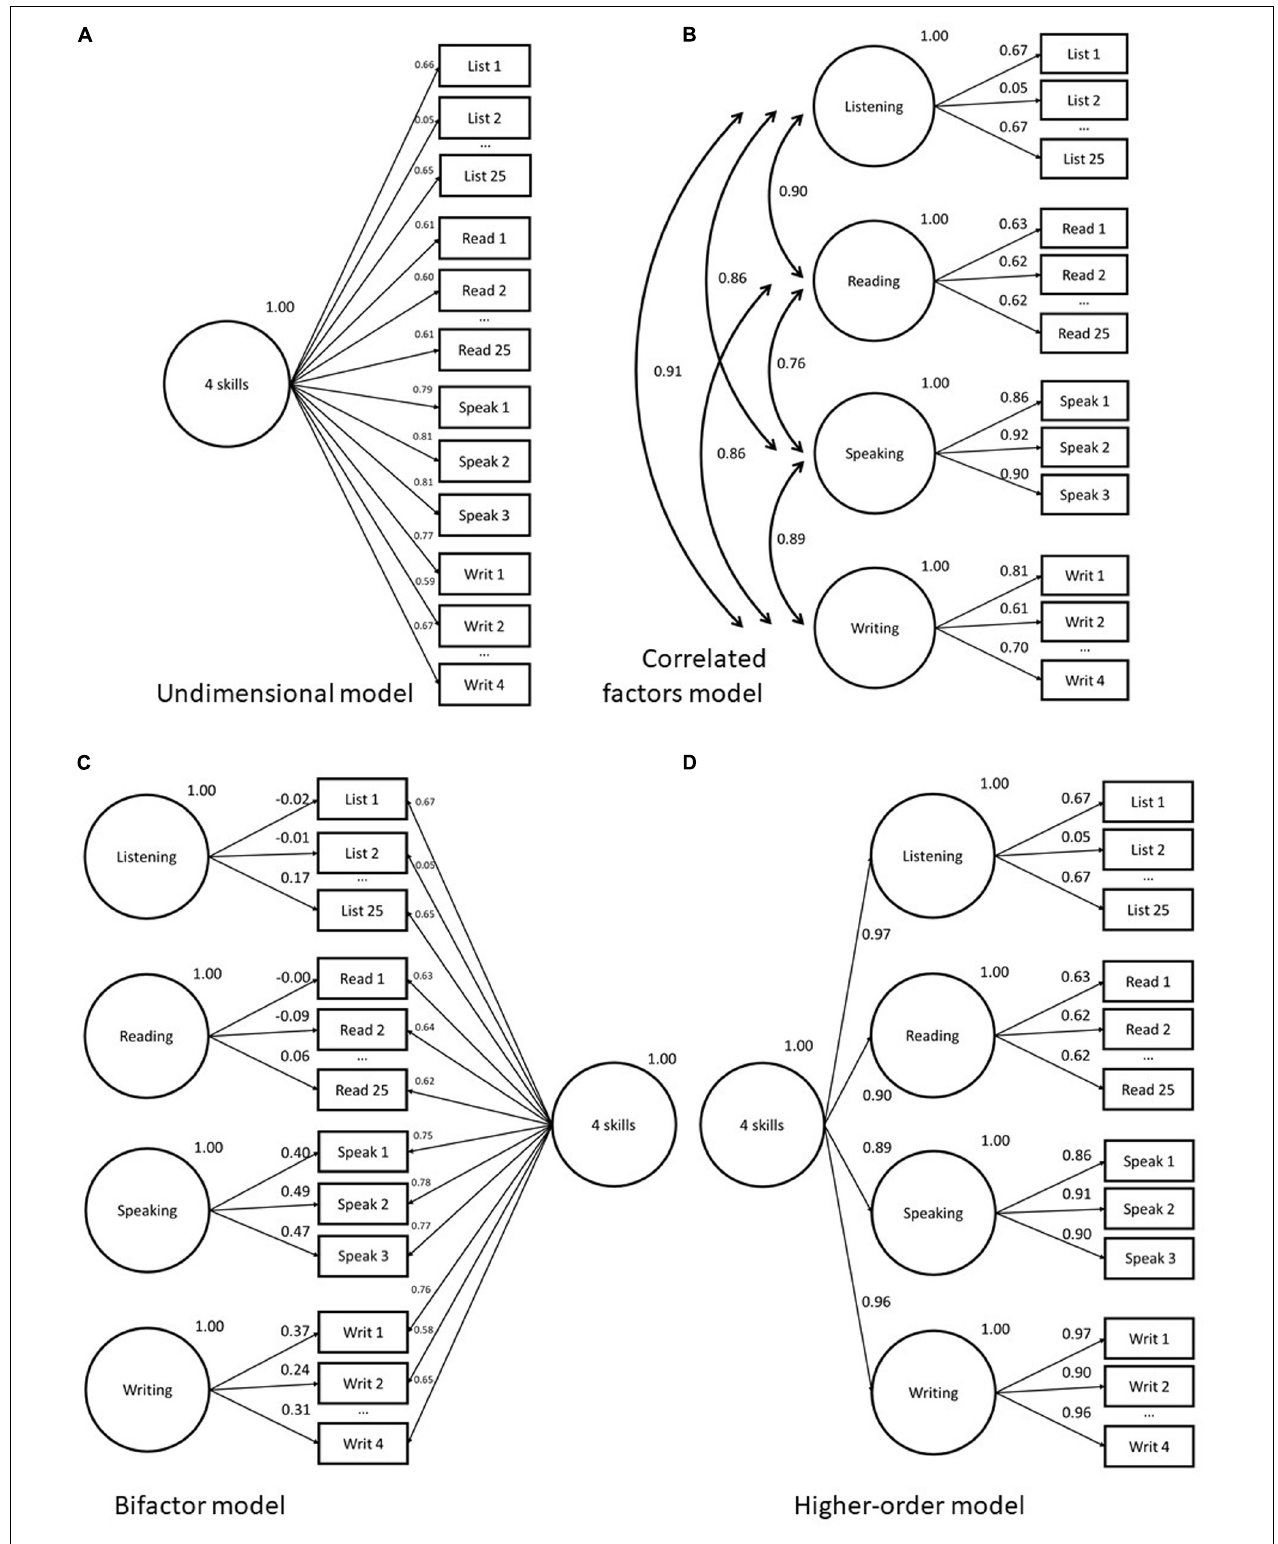
FIGURE 2 | Abbreviated factor loading diagrams for CFA models fit to four-skill dataset in study 2. Models as follows: (A) Unidimensional; (B) Correlated factors; (C) Bifactor; (D) Higher-order.